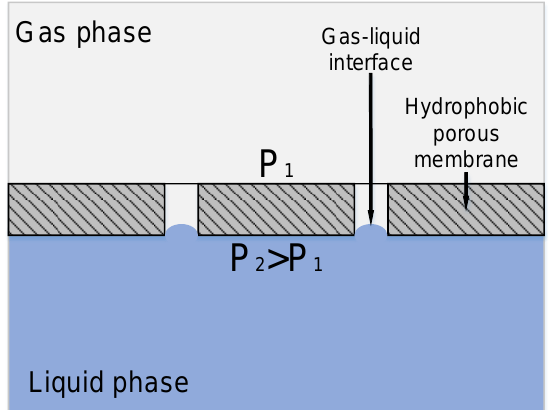
Figure 2. Principle of mass transfer in a membrane contactor based on a symmetric hydrophobic porous membrane.